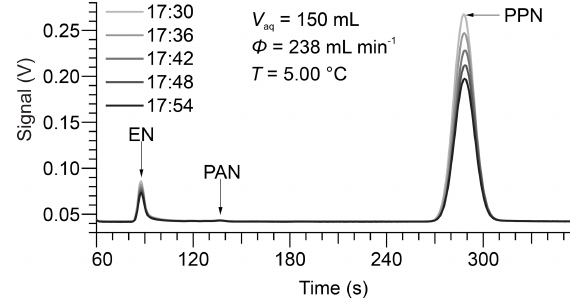
Figure 2. Sample chromatograms recorded by the Varian GC-ECD operated with N 2 carrier gas at a flow rate of 40mLmin − 1 . Here, the GC sampled the gas eluting from 150mL DI water at a tempera- ture of 5.00 ◦ C at a volumetric flow rate of 238mLmin − 1 . The GC injected automatically every 360s, at the time (HH:MM) shown in the